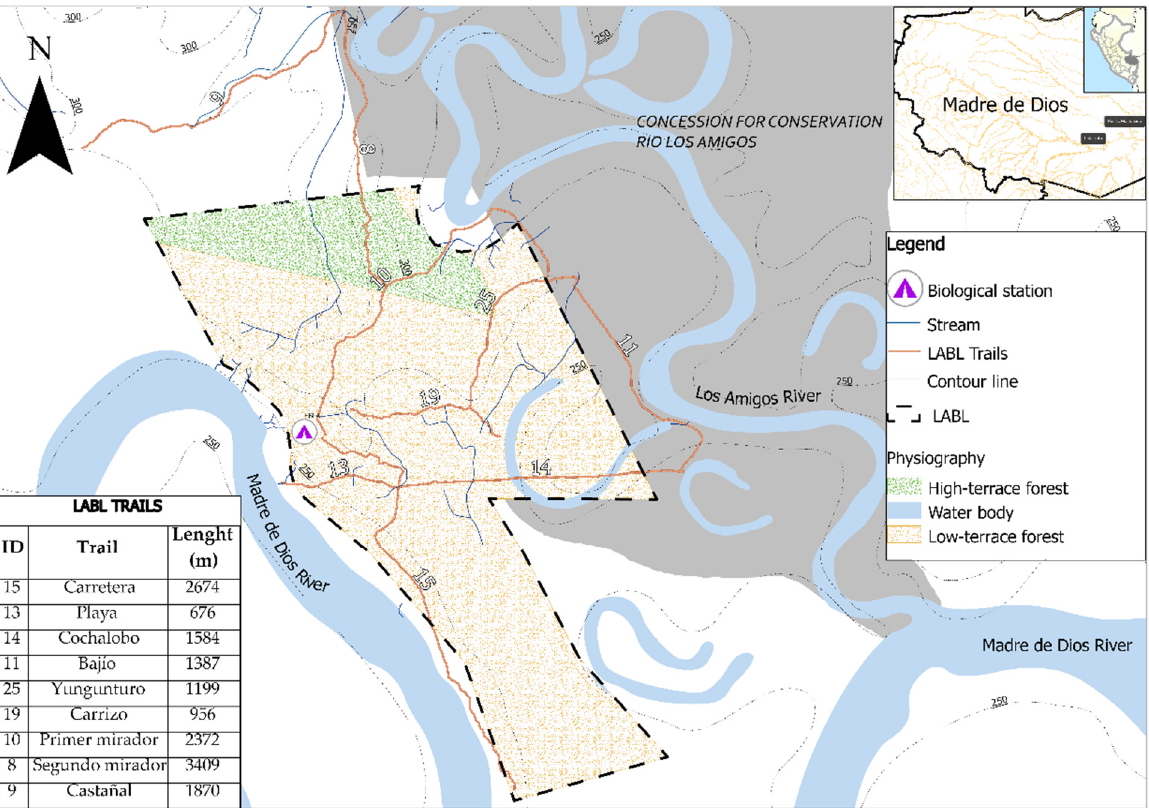
Figure 1. Location map of the study area in the “Los Amigos” Biological Station in the Madre de Dios Region, Peru. LABL: “Los Amigos” Biological Station.